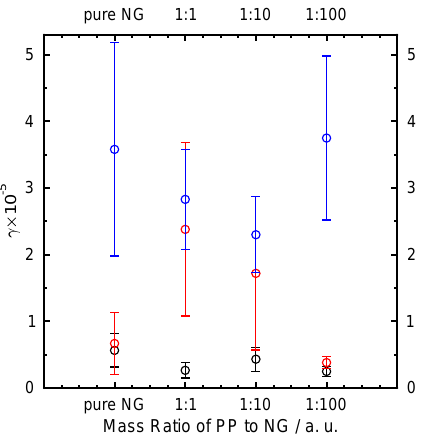
Figure 6. Steady-state reactive uptake coefficients, γ , as a function of mass ratio of Pahokee peat to 5-nitroguaiacol. Black, red, and blue open circles denote dark, VIS, and UV irradiated uptake ex- periments, respectively. Errors bars denote 1 σ of the mean γ